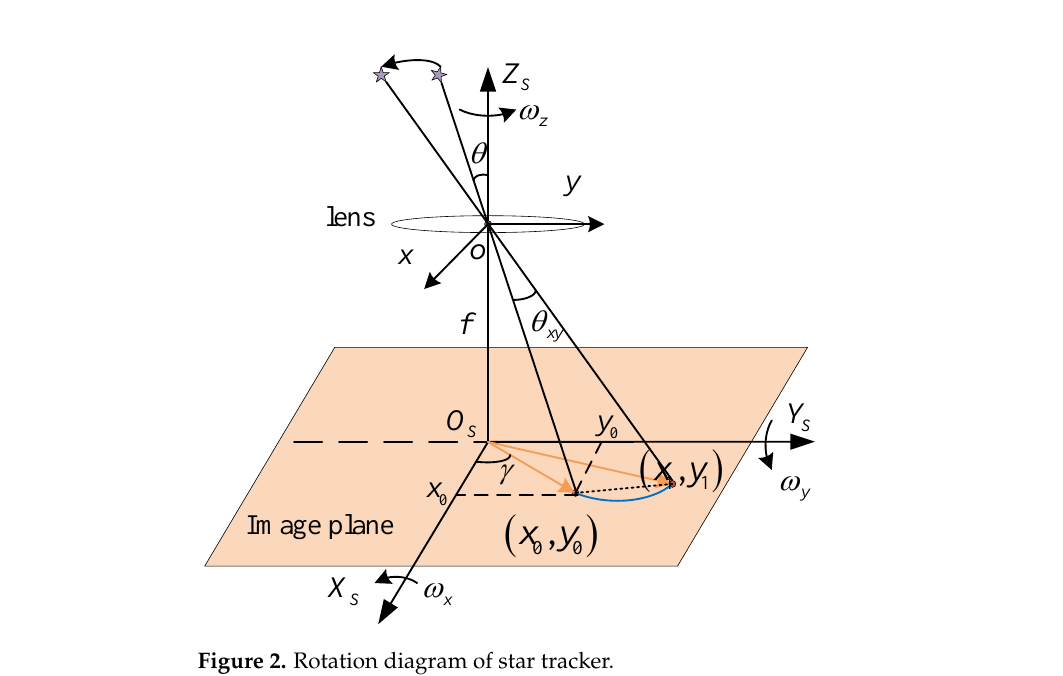
Figure 2. Rotation diagram of star tracker.